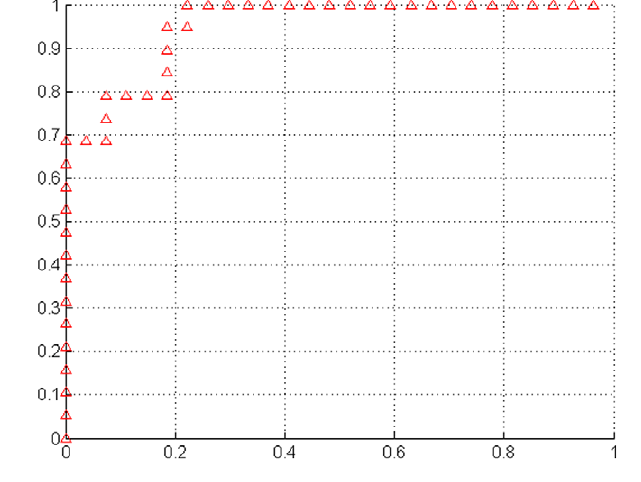
Figure 2. Classification performance of the multi-model method. The ROC curve of the classifier. The area under the ROC curve was 0.951.